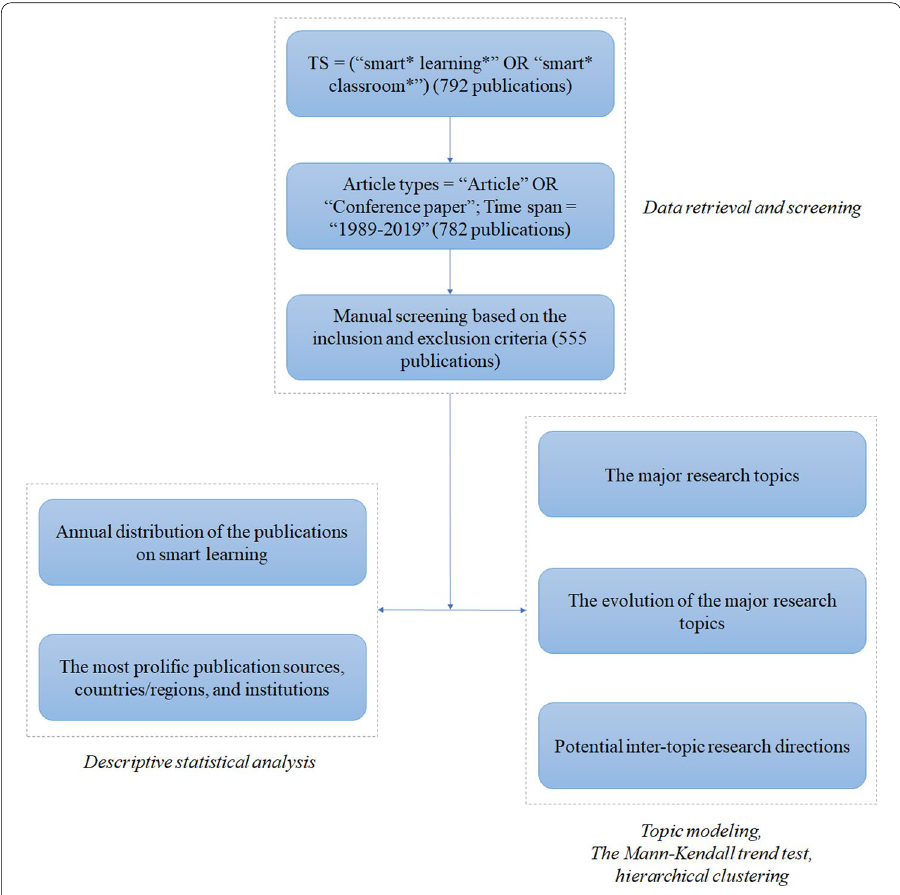
Fig. 1 Framework of data collection and